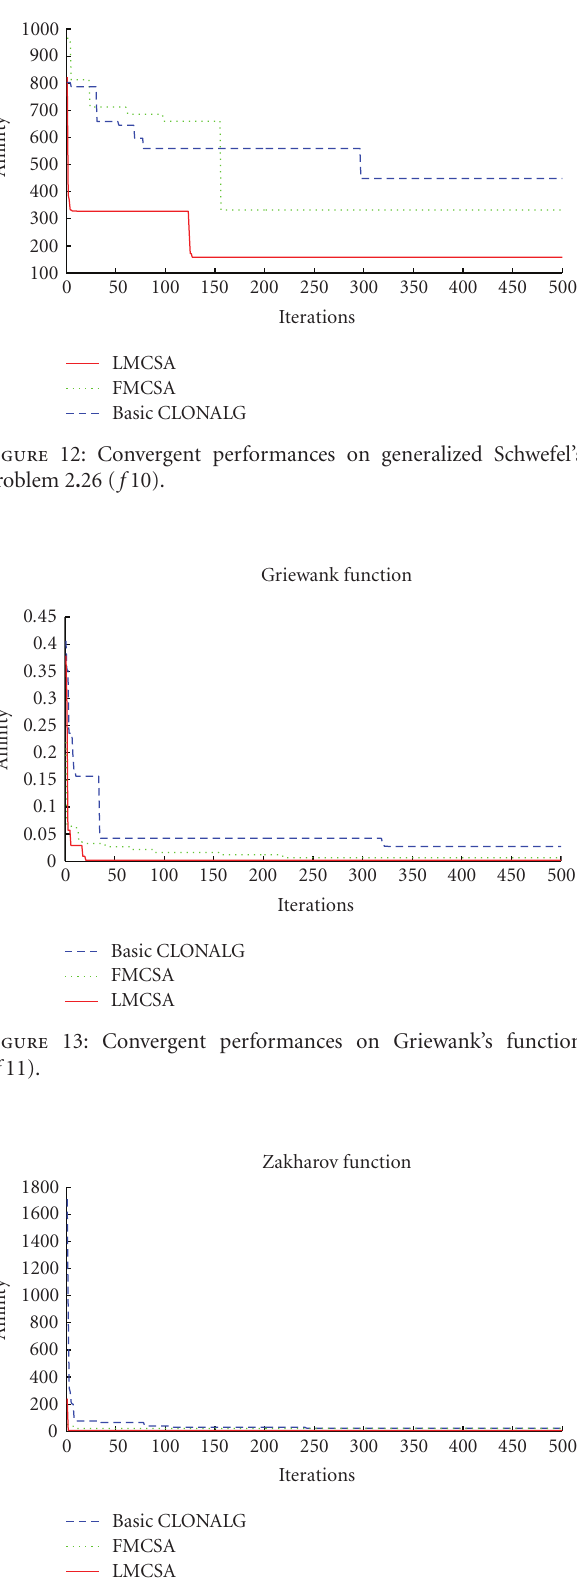
Figure 14: Convergent performances on Zakharov’s function ( f